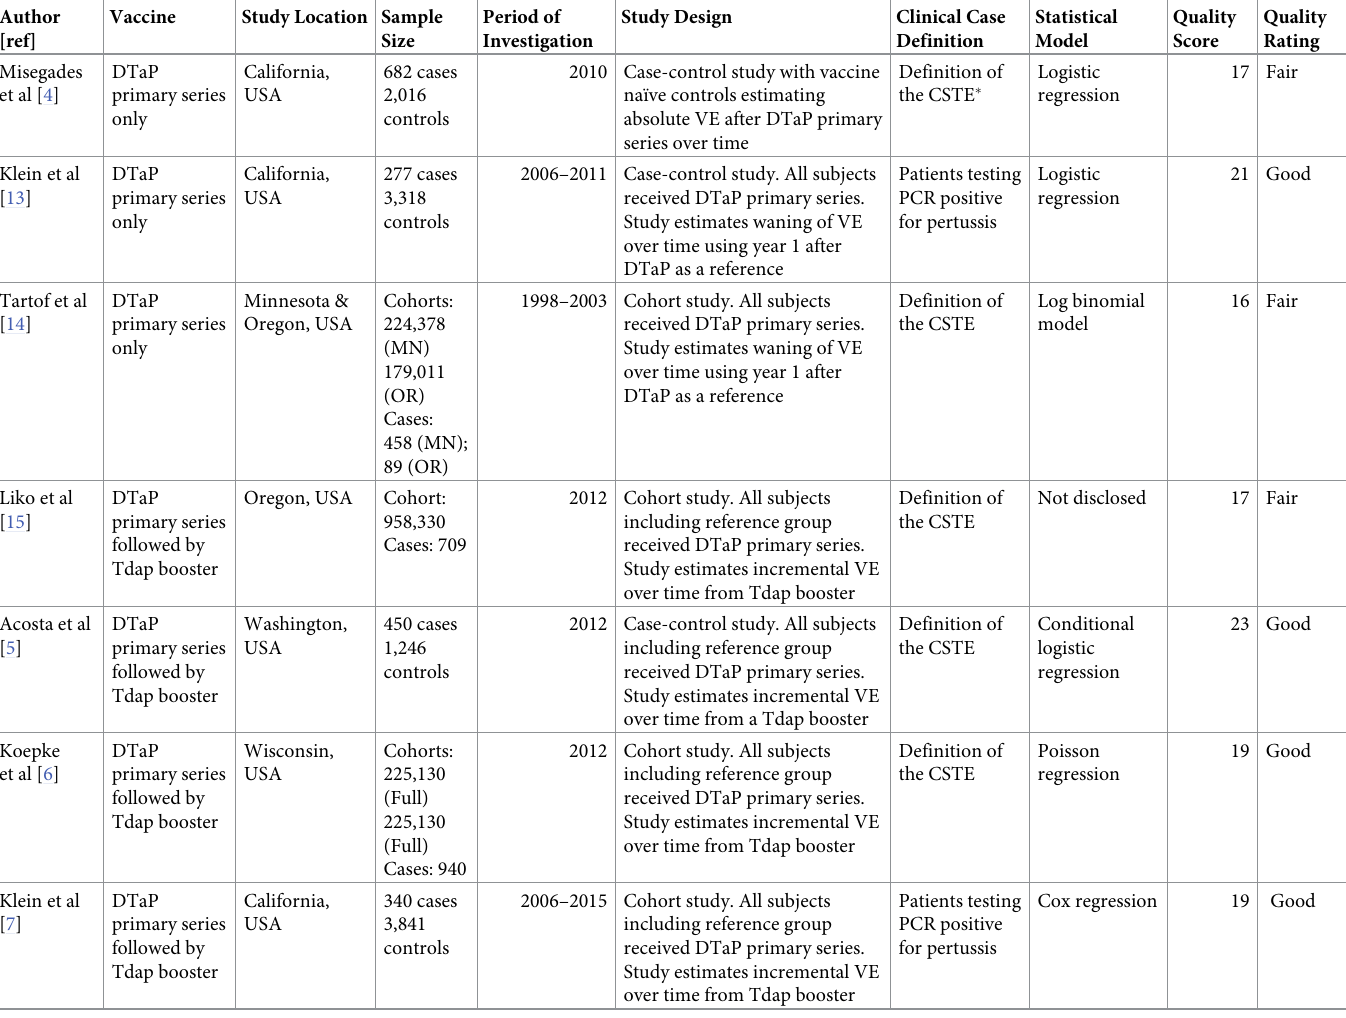
Table 1. Summary of publications included in